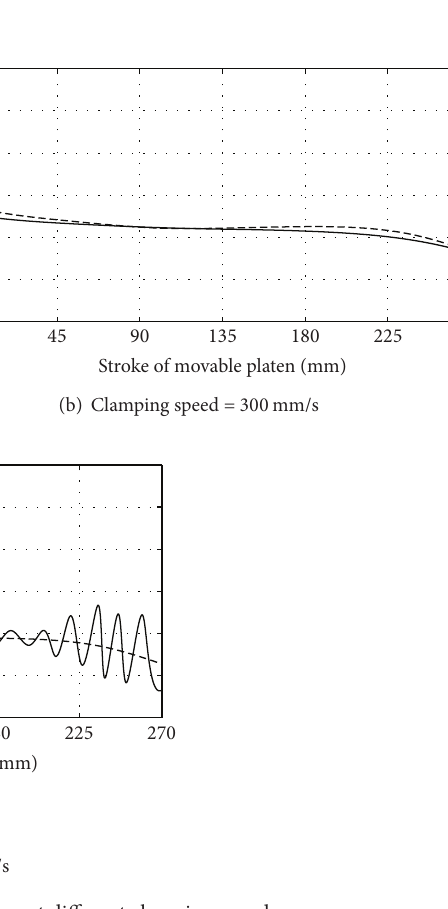
Figure 10: Vibrating displacement of K point in 𝑋 direction at different clamping speed.